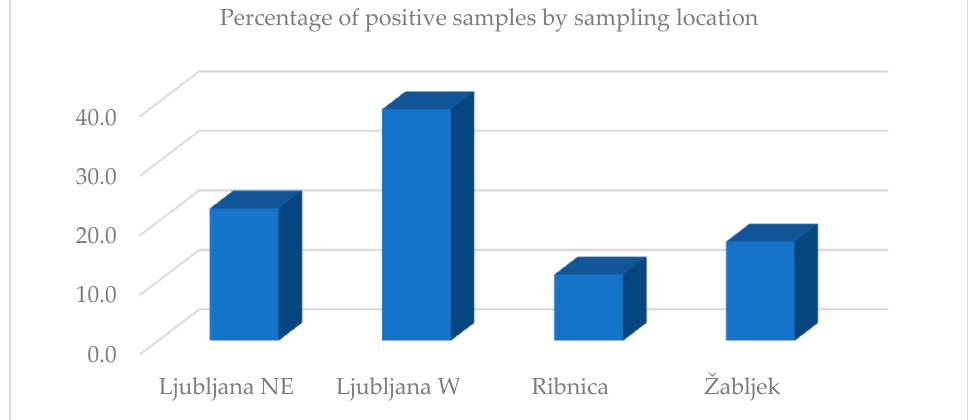
Figure 2. Percentage of positive butterfly samples compared by sampling location.